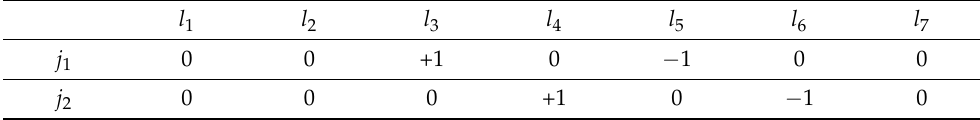
Table 4. Dilution constraints matrix, B , for the illustrative